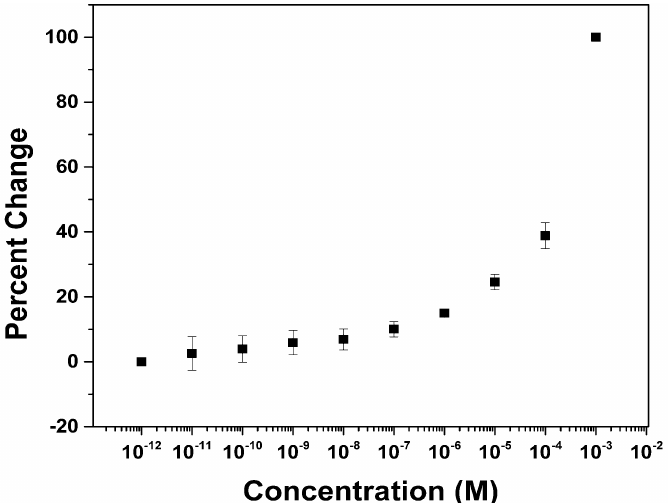
Figure 4. Curve for the nonspecific binding of BSA to an array coated with a PEG functionalized